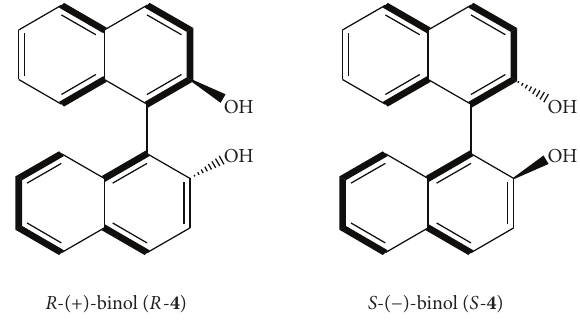
-dihydroxy-1,1 -binaphthyl ( 4 , and S - 4 , of 2,2 � �